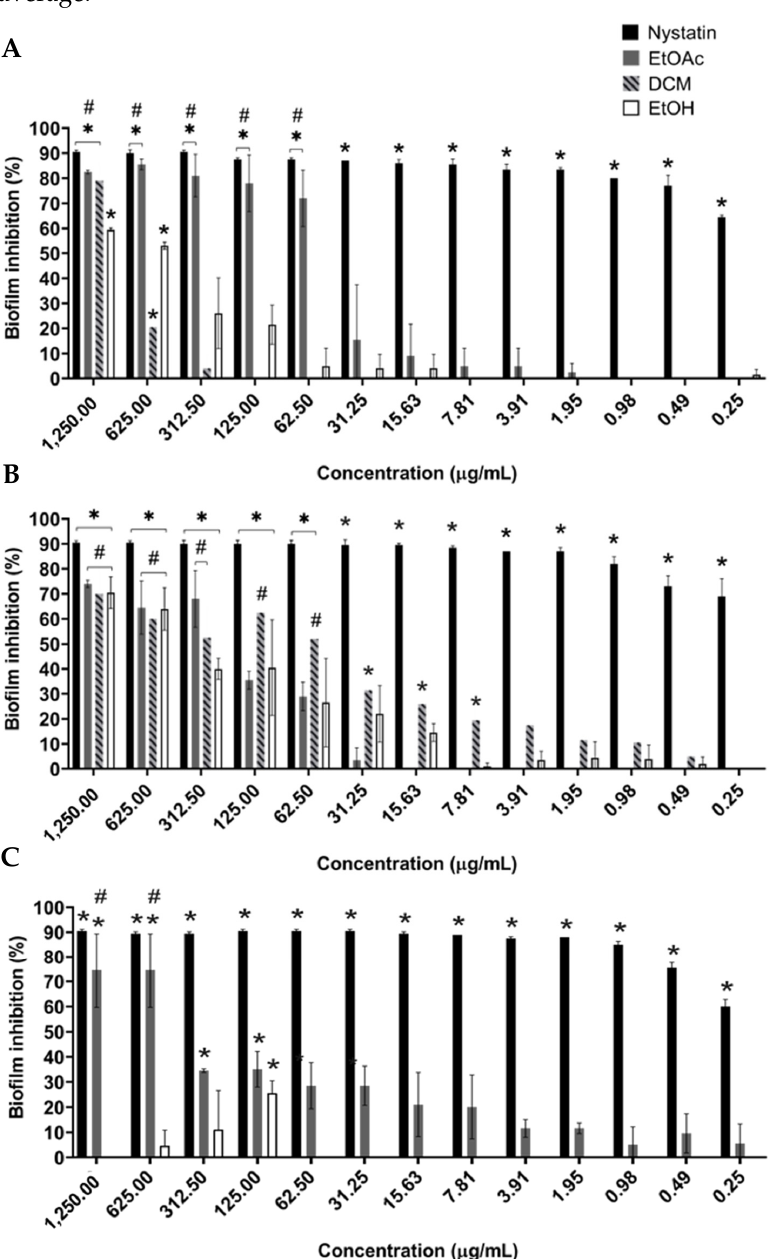
Figure 2. Effect of Bauhinia holophylla fractions on biofilm formation of Candida albicans strains . ( A ) C. albicans SC5314; ( B ) C. albicans ATCC 18804; ( C ) C. albicans ATCC 10231. The metabolic activity represented by the C. albicans biofilm was compared with the untreated control. The results between groups were compared using Tukey’s test, and Dunnett’s test was used to compare the results between the treatments and the control. Each value is presented as the mean ± standard deviation of two independent experiments (* p -value < 0.05). (#) fractions and concentrations do not differ from each other. EtOAc: ethyl acetate fraction; DCM: dichloromethane fraction; EtOH: hydroethanolic